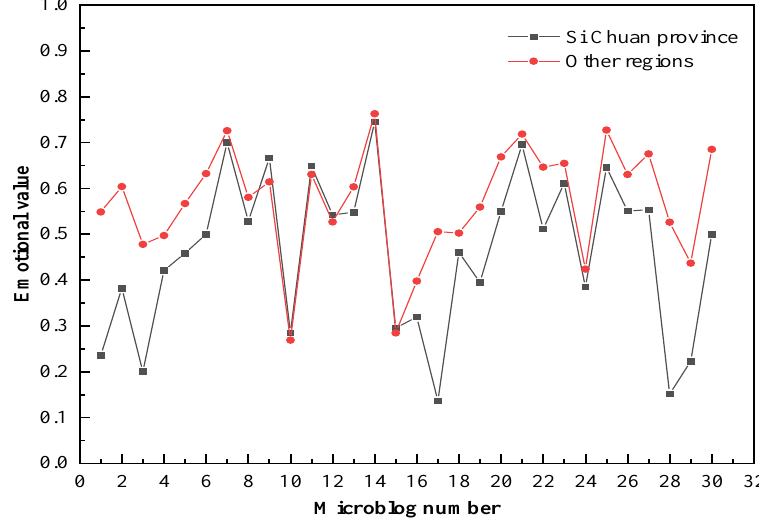
Figure 5. Regional Sentiment Comparison Chart.